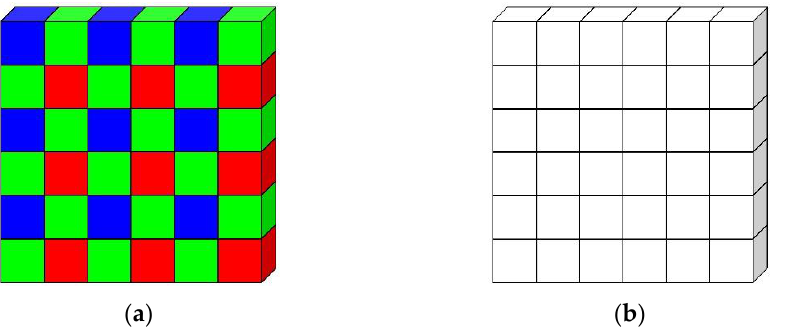
Figure 1. Structure of the camera sensor: ( a ) Bayer pattern of the color camera and ( b ) mono camera. Burduja et al. [23] performed intracranial hemorrhage detection by using color images merged from three grayscale images that extracted different features from one CT